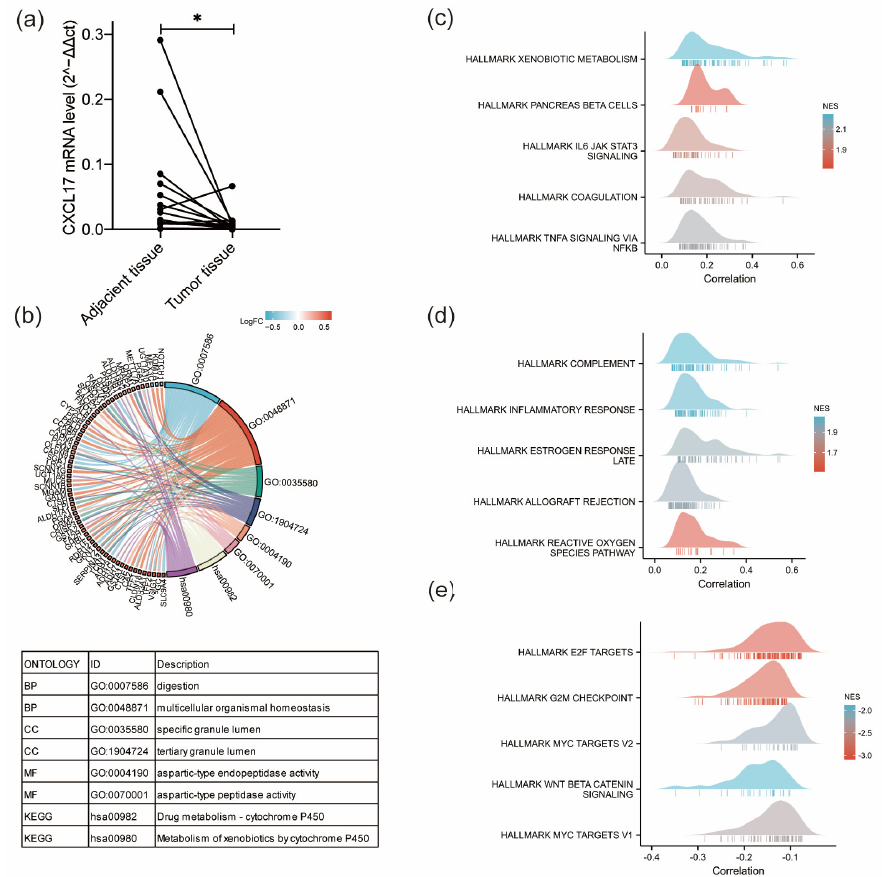
Figure 7. Potential function and pathways of CXCL17 by GO, KEGG, and GSEA analyses. ( a ) CXCL17 mRNA levels in GC and adjacent GC tissue detected in 16 paired tissues. * p < 0.05. ( b ) GO and KEGG analysis of CXCL17. The top 10 positively enriched GSEA pathways of CXCL17 ( c , d ). The top five negatively enriched GSEA pathways of CXCL17 ( e ).